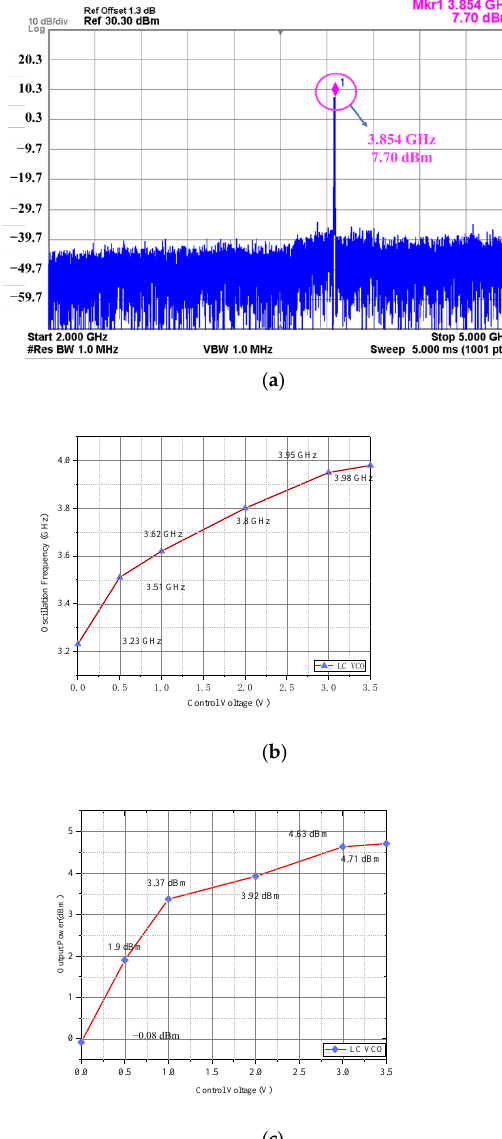
Figure 7. The measurement results of the VCO: ( a ) the spectrum of the VCO; ( b ) the tuning range of the VCO; ( c ) the output power of the VCO.